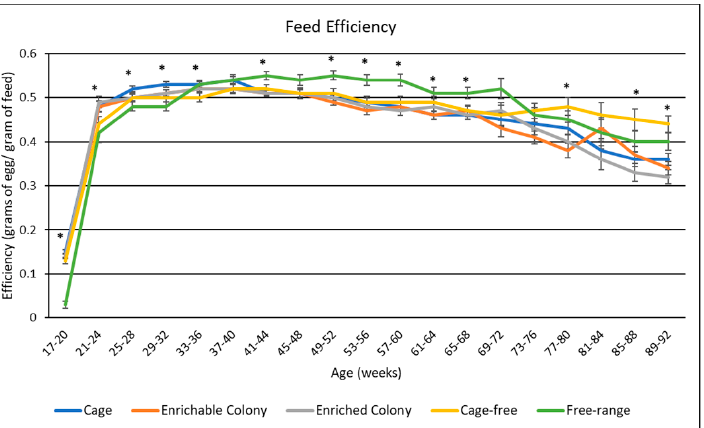
Figure 4. The effect of housing environment on feed efficiency of brown egg layers by age. * Signifies a significant effect ( p < 0.05) of housing environment by age range on feed efficiency.